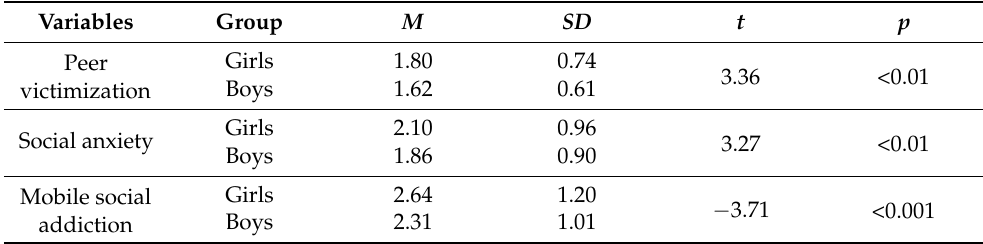
Table 1. Test for gender differences in the variables.